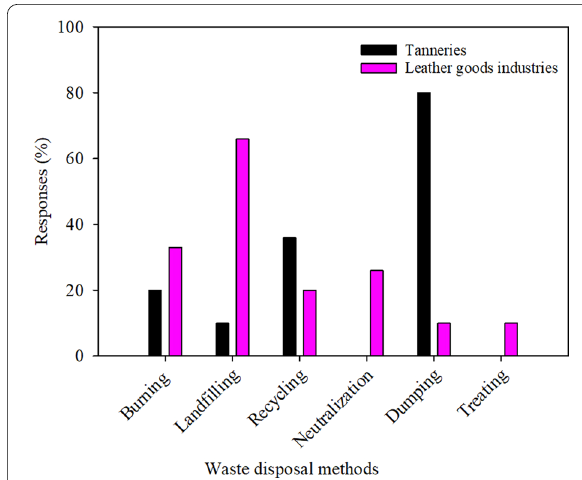
Fig. 6 Methods used to dispose